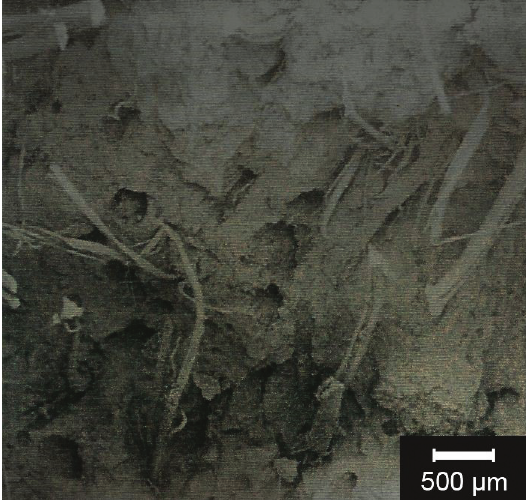
Figure 2. Fracture surface of a 25 mm fiber reinforced bend